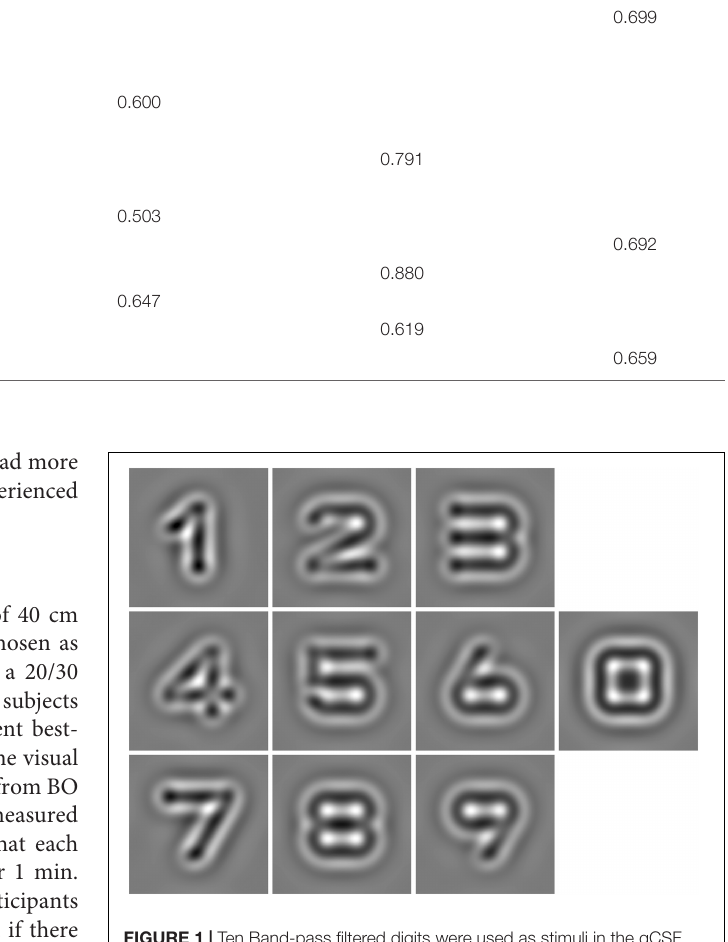
FIGURE 1 | Ten Band-pass filtered digits were used as stimuli in the qCSF